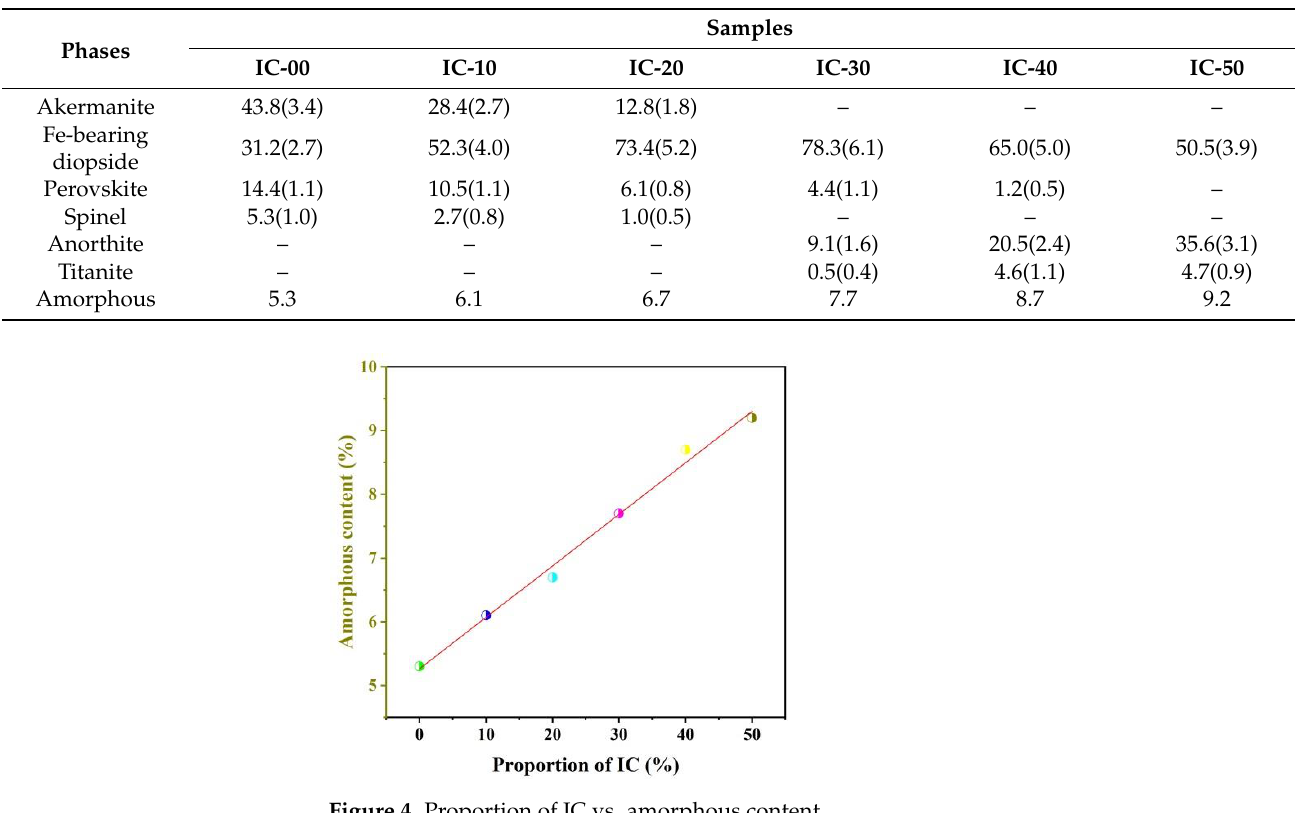
Table 4. Relative contents of phases in the ceramic samples.